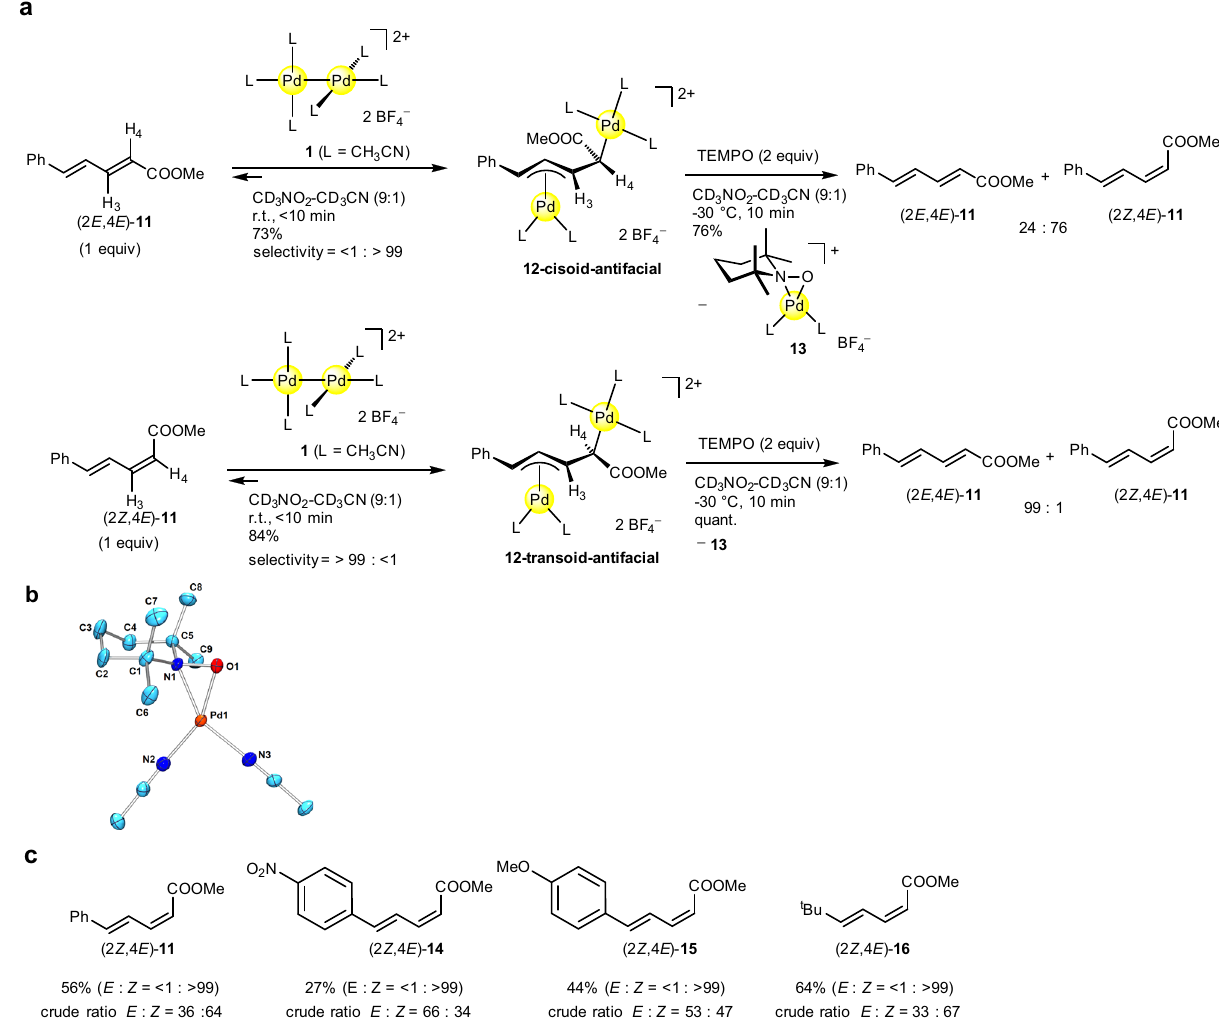
Fig. 3 Isomerization of ( E , E )-diene to ( Z , E )-diene. a Reaction scheme to access (2 Z ,4 E )-isomer of methyl 5-phenylpenta-2,4-dienoate ( 11 ) through geometric isomerization. b ORTEP for 13 (50% probability ellipsoids; counter anion is omitted for clarity). c Yields of (2 Z ,4 E) -1,3-dienes from the corresponding (2 E,4E )-1,3-dienes. Typically, the diene was added to a solution of 1 in CH 3 NO 2 /CH 3 CN ( v / v = 95:5) at room temperature, and stirred for 15 min. The reaction mixture was then cooled to − 20 °C and a solution of TEMPO (4 equiv) was added and stirred for 5